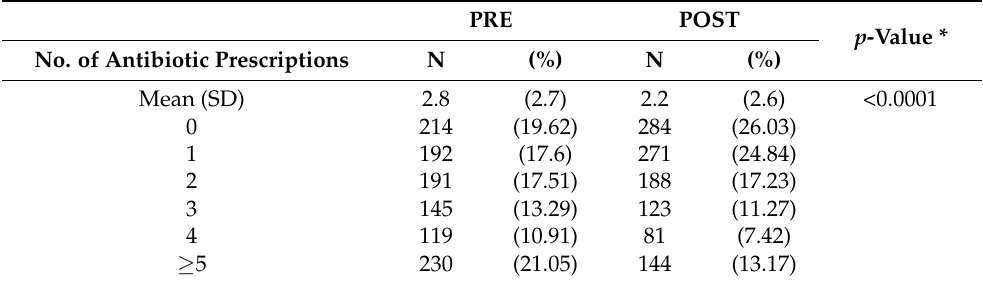
Table 2. Antibiotic prescriptions’ frequency in 1091 children included in the PRE and POST period. Pedianet, 2007–2017.